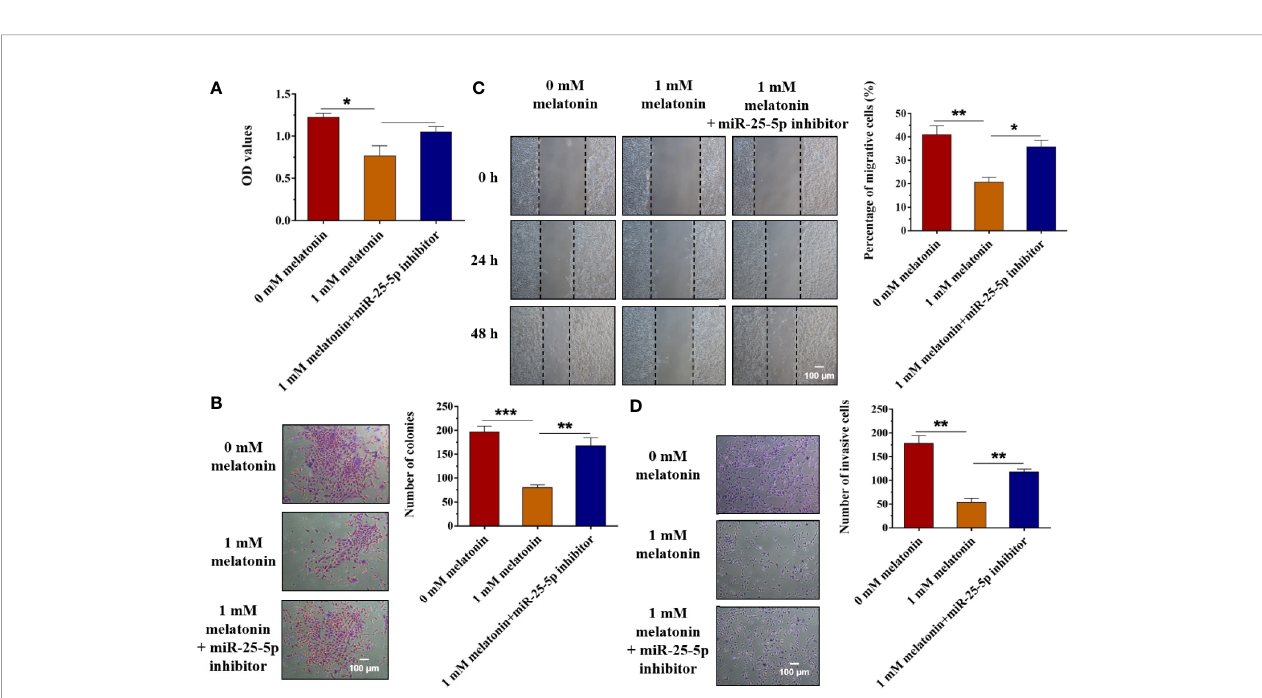
FIGURE 7 | Inhibition of miR-25-5p reverses the inhibitory effects of melatonin in OSCC cells. (A) SCC9 cells were treated with melatonin at 1 mM and miR-25-5p inhibitor, and MTT assay was performed to detect the cell viability. (B) SCC9 cells were exposed to 1 mM melatonin and miR-25-5p inhibitor and then were subjected to colony formation assay to examine SCC9 cell proliferation ability. (C) Effects of melatonin on the migration of SCC9 cells in the presence of miR-25-5p by wound healing assay. (D) The invasion ability of SCC9 cells after melatonin treatment and miR-25-5p transfection by Transwell invasion assay. (n=4, One way ANOVA followed by the Tukey ’ s test, * indicated the differences compared with 0 mM Melatonin group,*p < 0.05, **p < 0.01, ***p < 0.001, Scale bar, 100 m